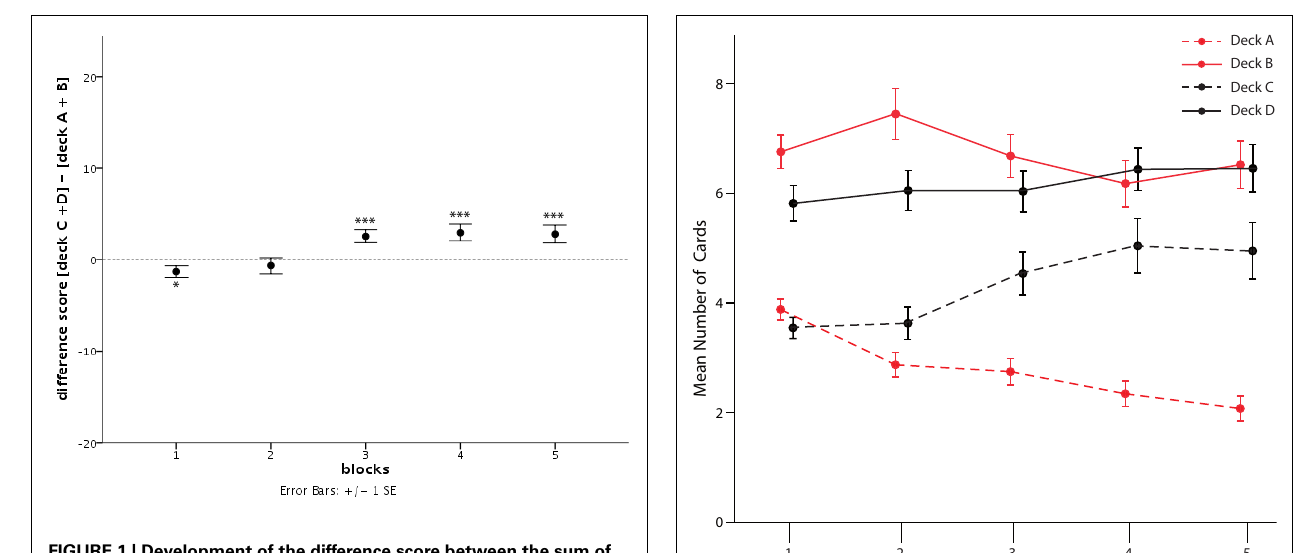
FIGURE 1 | Development of the difference score between the sum of cards drawn from advantageous decks C and D and disadvantageous decksA and B over five consecutive blocks of 20 cards of the Iowa GamblingTask. Bars represent SE of the mean (SE), asterisks indicate the Table 3 | Mean number of cards drawn from each deck for the five consecutive blocks (each containing 20 choices) of the Iowa GamblingTask.